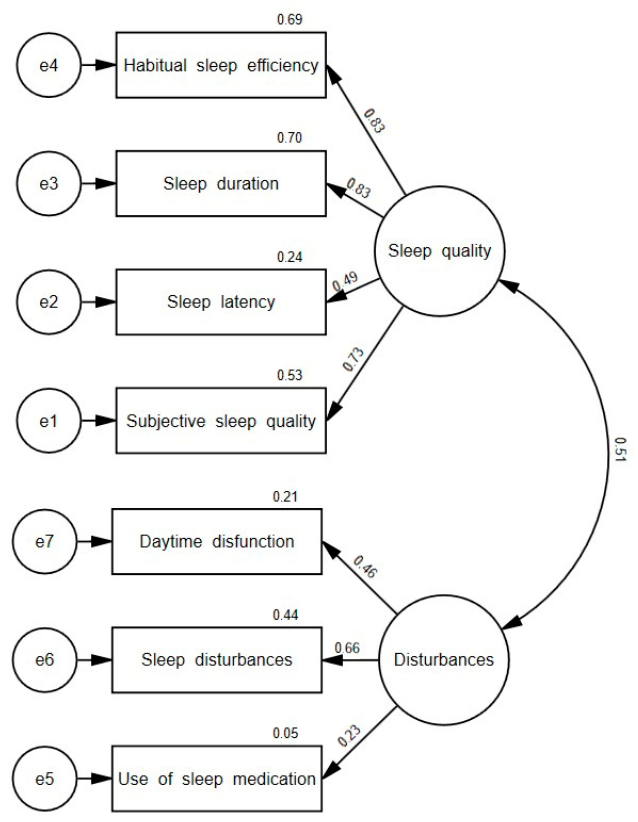
Figure 1. Factor loadings for the two-factor